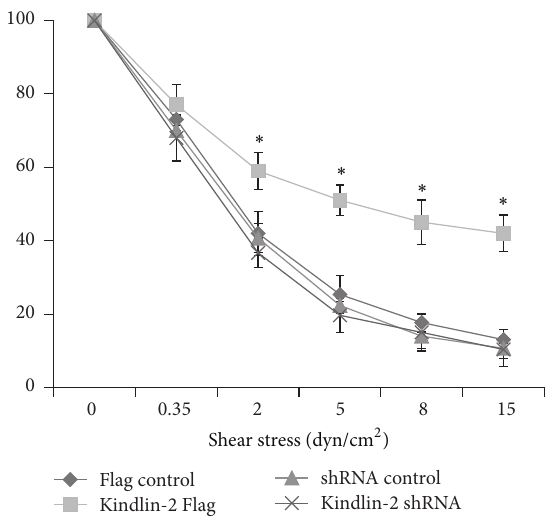
Figure 5: Kindlin-2 boosts iPSC-MSCs adhesion to slides coated with VCAM-1 + SDF1 𝛼 . The iPSC-MSCs transfected with Kindlin-2 Flag and shRNA adhered to the flow chamber slide coated with VCAM-1/SDF-1 𝛼 under shear stress. Kindlin-2 Flag transfected iPSC-MSCs had significantly higher attachment to the slides cocoated with VCAM-1 + SDF-1 𝛼 under shear flow velocities of 0, 2, and 5 dynes/cm 2 with 10x magnification compared to control Flag. The values shown are mean ± SEM of three independent experiments. ∗ Significance difference against Flag control 𝑝 ≤ 0.05 .